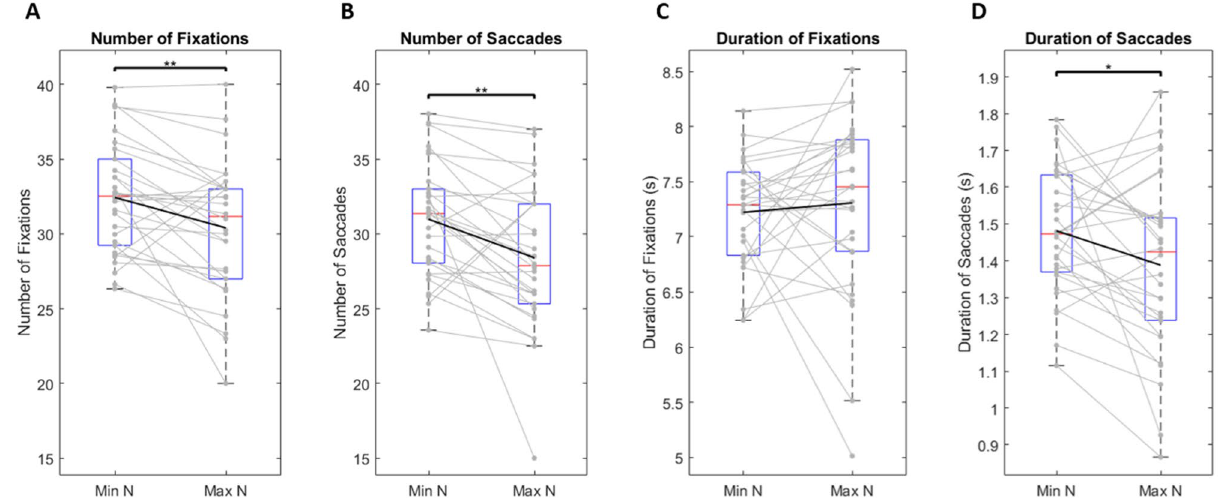
Figure 8. Average number ( A , B ) and duration ( C , D ) of fixations ( A , C ) and saccades ( B , D ) made by each subject at their minimum and maximum N-back achieved. Black line represents mean values. Solid gray lines represent individual subjects. Red lines represent median values. Blue boxes represent the IQR where each lower bound signifies Q1 and each upper bound signifies Q3. Lower and upper bounds of grey dotted lines represent minimum and maximum values, respectively. Points that lie outside these bounds are considered outliers. One star represents a significance value of p < 0.05, two stars represents a significance value of p < 0.01, and three stars represents a significance value of p < 0.001. Number is represented as the total number of fixation or saccade events made during a trial. Duration is represented as the total cumulative sum of all fixation or saccade events during a trial. Each plot demonstrates the average number or duration of fixations or saccades at each subject’s minimum N-back (N = 0 for all subjects), compared to their maximum N-back (variable across subjects).